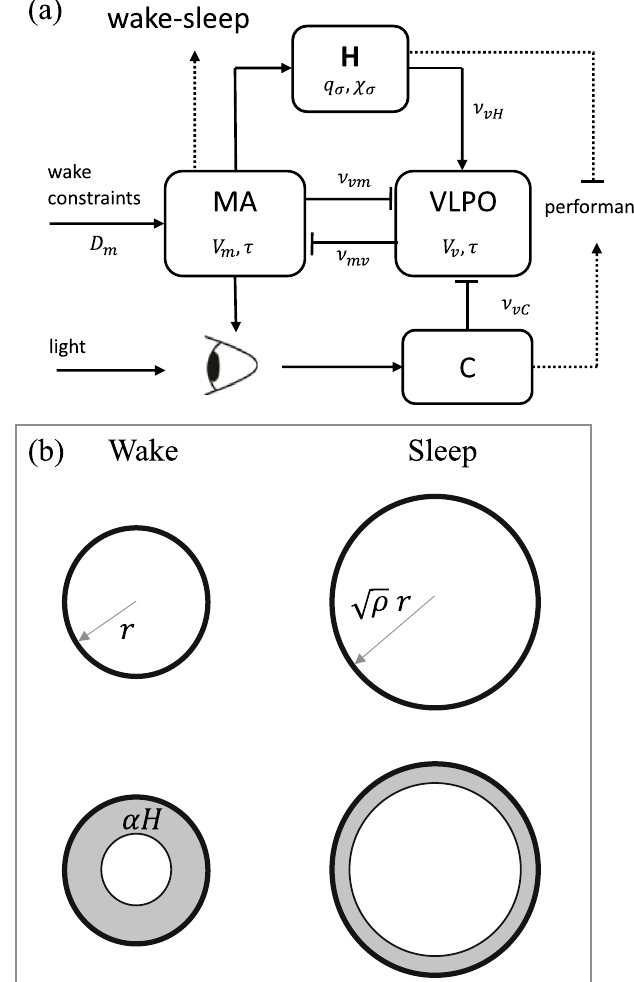
Figure 1. Model schematics. ( a ) Model of arousal dynamics incorporating key interactions between the homeostatic drive H , circadian drive C , and the sleep- and wake-active neuronal populations, VLPO and MA nuclei. Bar-headed lines indicate inhibitory connections, while the arrows show excitatory action. Dotted lines show relevant model outputs—sleep times and alertness. Constraints, such as sleep restriction are incorporated through action of the MA nuclei. See text for parameter descriptions. ( b ) Schematic cross section of an interstitial void during wake and during sleep with unobstructed flow (top) and obstructed flow (bottom) due to build up of waste products, shown shaded. The void radius increases during sleep by a factor of absence of clearance, the area α H obstructed due to the effects of waste products is the same during wake and